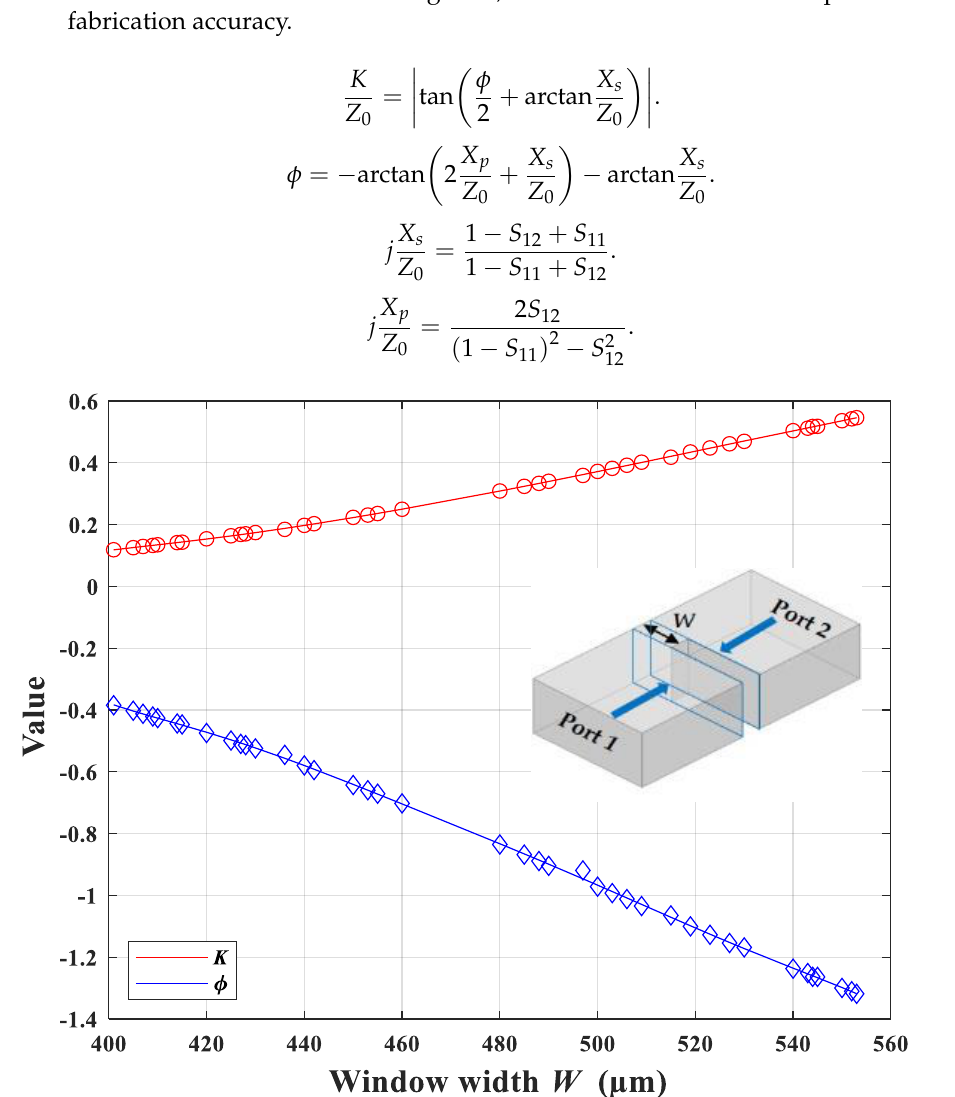
Figure 2. The relationship between the inverter value K , the electric length ϕ , and the window width W for an inductive iris in a WR-3.4 waveguide. The iris thickness is set to 100 µ m. The inset shows the iris model and the de-embedded planes.